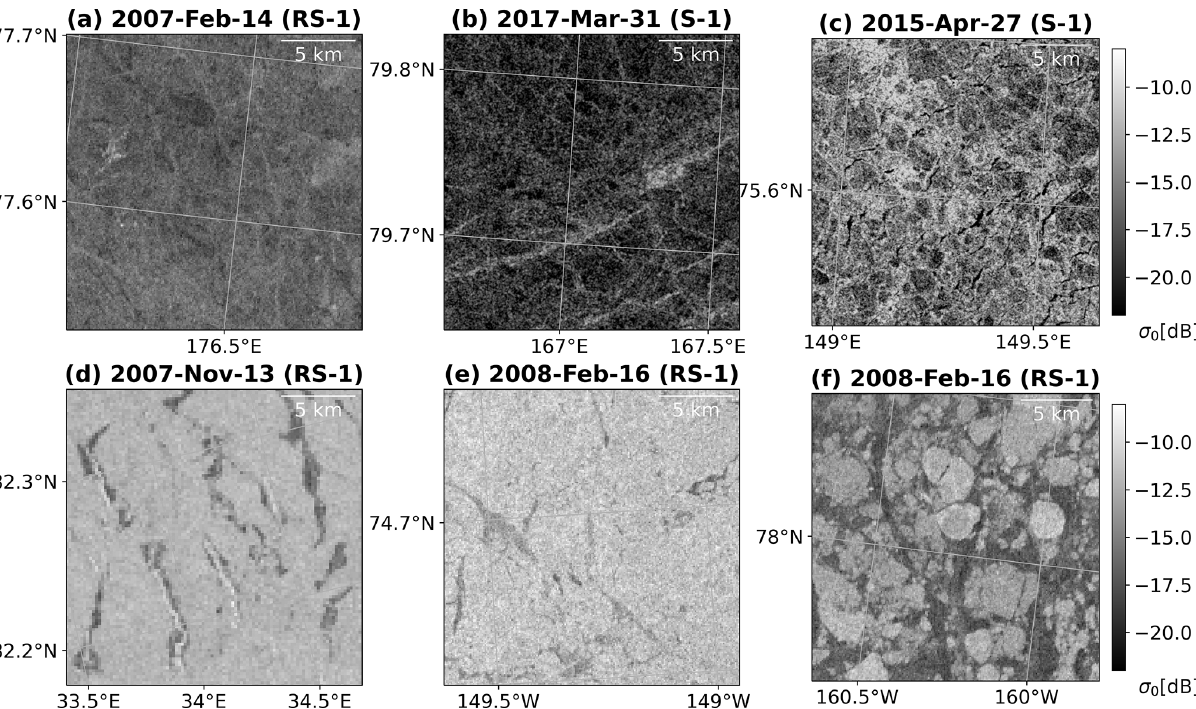
Figure 3. Scenes of SAR images (C-band, HH polarization) showing different sea ice features. (a) FYI with smooth textures, (b) FYI with ridged ice in bright linear features, (c) brash ice between ice floes, (d) refrozen leads with bright features, marked with red arrows, (e) MYI with bright backscatter, and (f) MYI floes in a matrix of